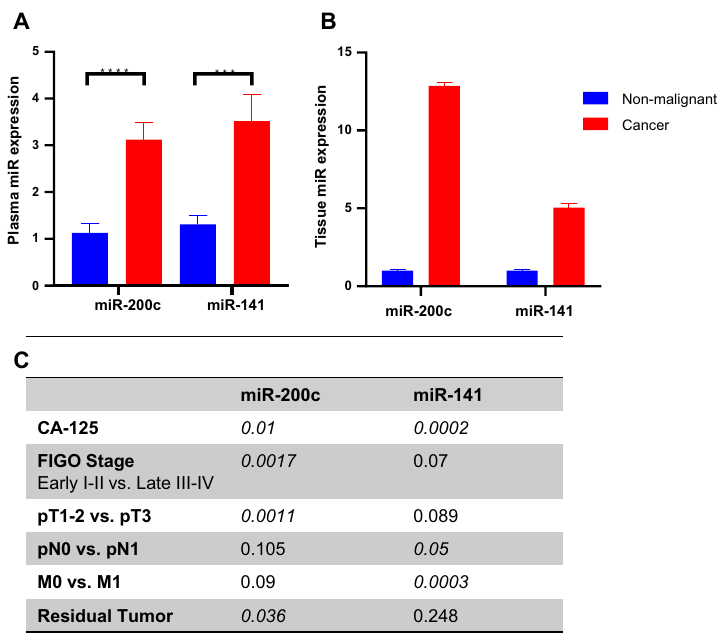
Figure 4. Circulating miR-200c and miR-141 are potential surrogate markers for OC. Expression levels of circulating miR-200c and -141 are significantly upregulated in OC cases compared to controls, as depicted by box plot with SEM ( A ). Both miR-200c and miR-141 expression is upregulated in a panel of OC tissues compared to benign tissues ( B ). Significance is calculated by a Mann Whitney test and depicted as ***P < 0.001 and ****P < 0.0001. The table below shows the correlation of circulating miRNA expression with clinical features of